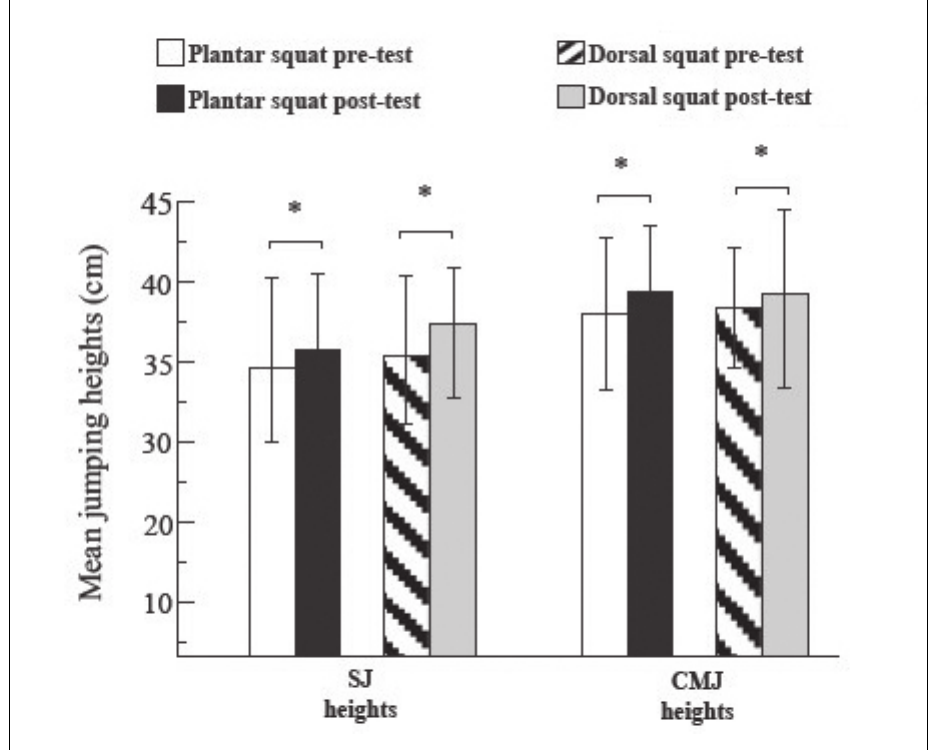
Figure 2. CMJ and SJ jumping heights before and after WBV in plantar and dorsal squat